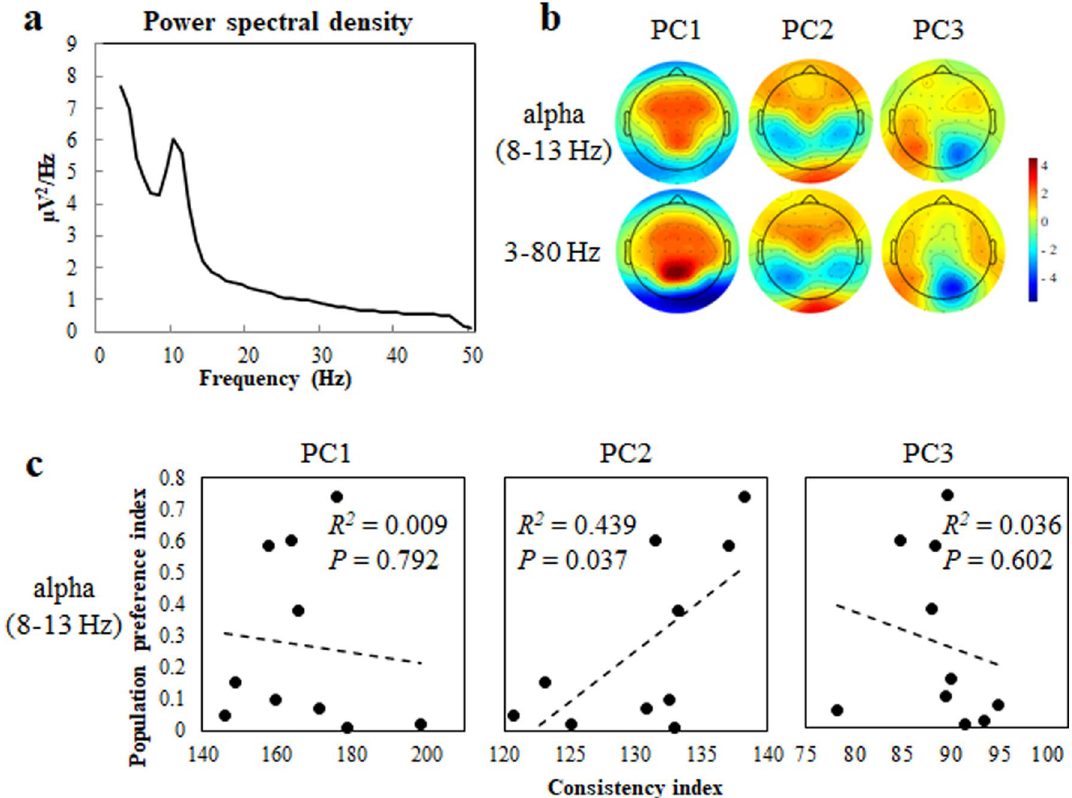
Figure 2. Neural activity patterns in the alpha band and population preferences. ( a ) Power spectral density of canonical variates averaged for the first three canonical variates, all TV commercials, and all participants. A characteristic peak is evident in the alpha band (~ 10 Hz). ( b ) Scalp topographies indicating PC1, PC2, and PC3 from canonical loadings of the first three correlated canonical components of alpha (top) and 3–80 Hz (bottom) bands while viewing the most popular TV commercial in the dataset. ( c ) Relationships between the population preference indices (as described for Fig. 1c) and consistency indices in the alpha band. Dashed lines indicate the linear regressions between the